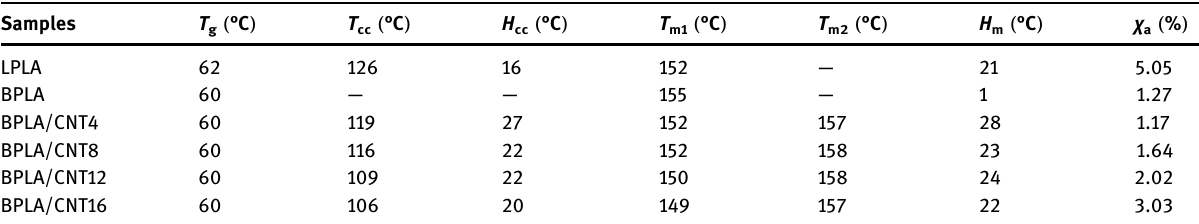
Table 1: Thermal property parameters of di ff erent PLA samples Samples